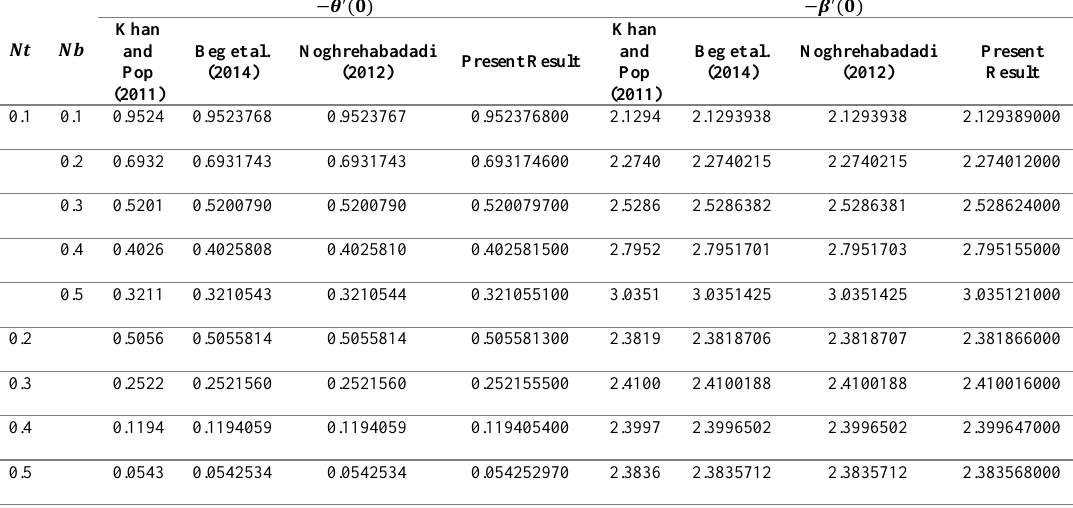
Table 1. Comparison of the results of −𝜃 ′ (0)& − 𝛽 ′ (0) when 𝑃𝑟 = 𝐿𝑒 = 10, 𝐸𝑐 = 0, 𝑎𝑛𝑑 𝑀 =